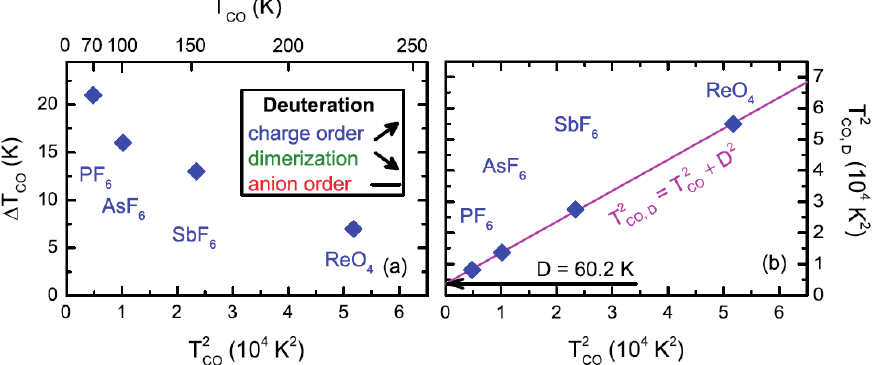
Figure 7. Effect of deuteration on charge order observed in (TMTTF) 2 X . ( a ) For several anions X = PF 6 , AsF 6 , Sb 6 and ReO 4 , the change in the transition temperature ∆ T CO = T CO,D − T CO is plotted versus the square of the CO transition temperature T 2 of pristine crystals. The increase is most pronounced CO for small and light anions. The inset indicates that deuteration rises the CO temperature, deminishes dimerization, but has no effect on AO. ( b ) Plotting T CO,D over T CO clearly reveals the dependence = T 2 + D 2 with D = 60.2 K. The data are taken from Reference [75,77]; the plot follows T 2 CO,D CO Reference